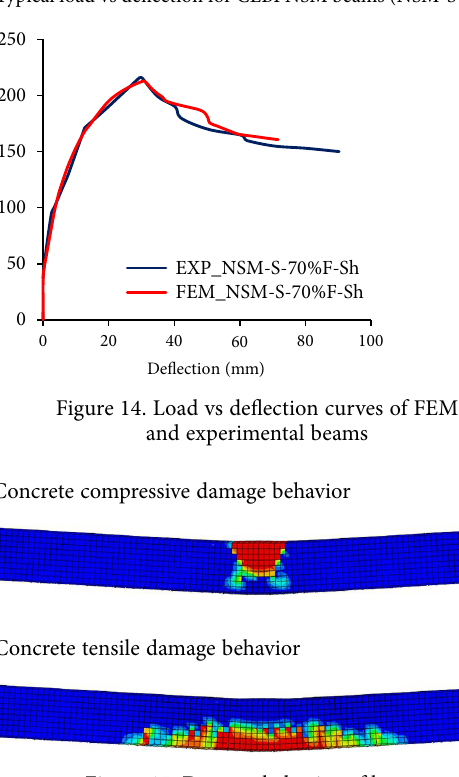
Figure 15. Damage behavior